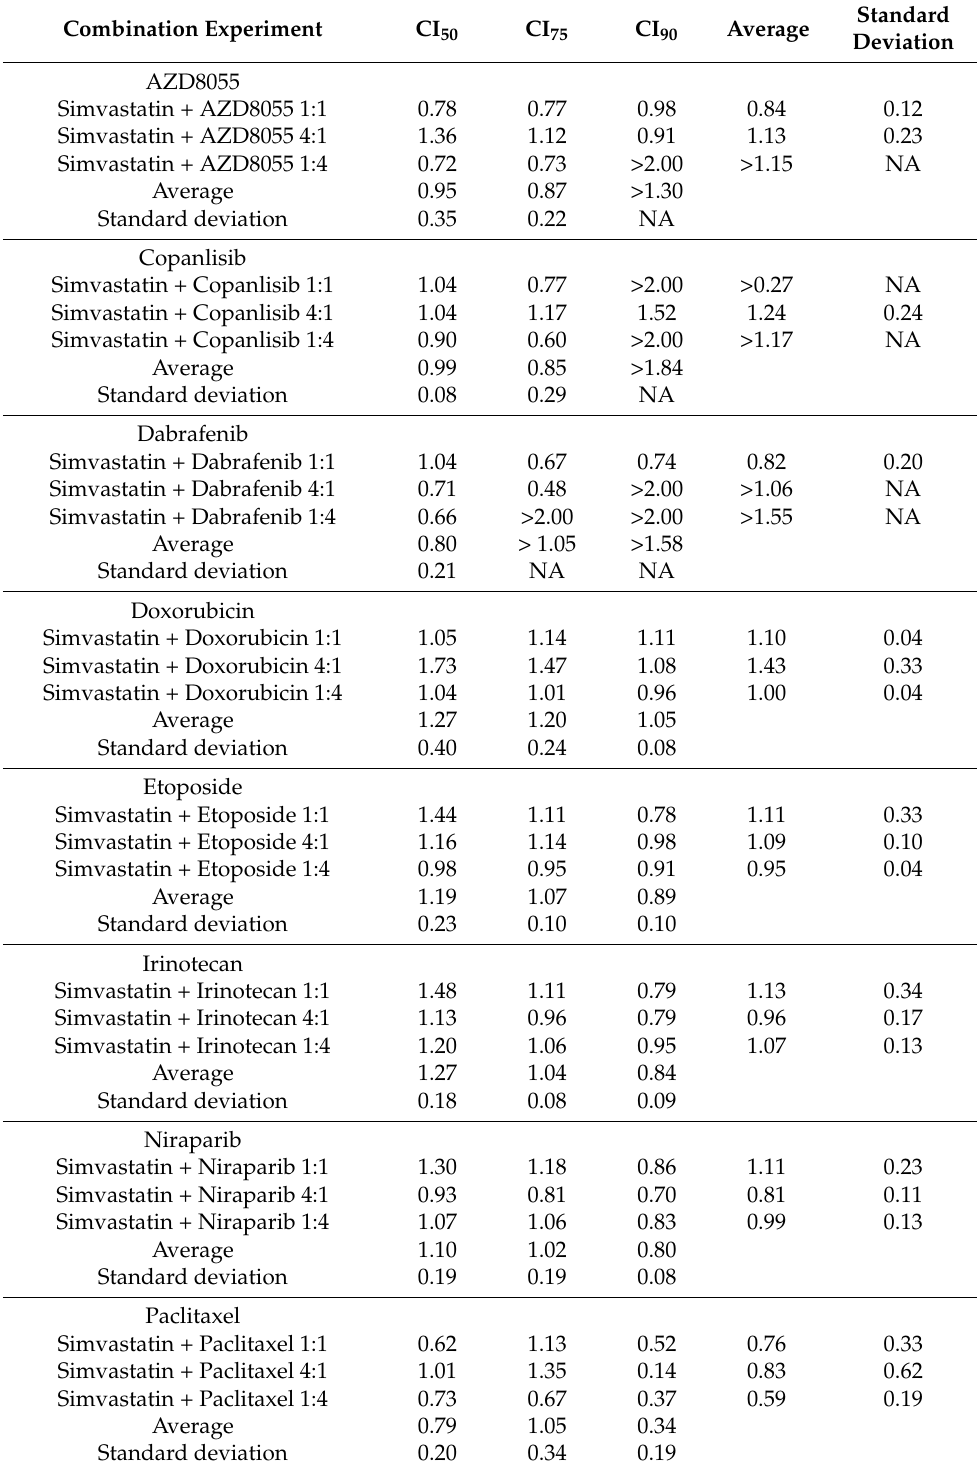
Table 3. Combination index (CI) between simvastatin and examined compounds calculated from the mixture data. CI 50 corresponds to 50% viability, CI 75 to 25% viability, and CI 90 to 10% viability. A representative value is the average CI value for the three